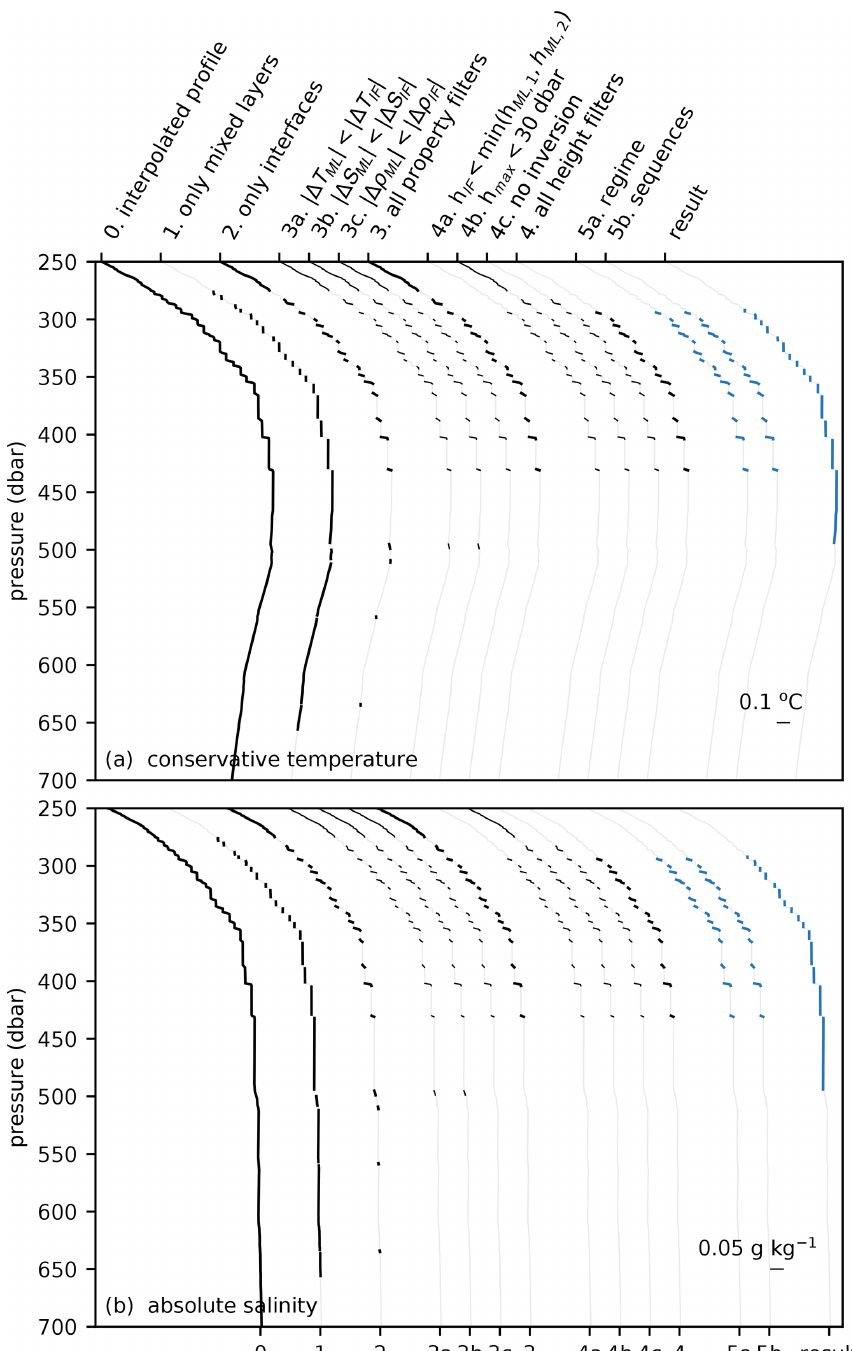
Figure A1. Steps of the detection algorithm applied to a profile in the Arctic Ocean, where steps are indicated on separate (a) conservative temperature and (b) absolute salinity profiles. Each profile is shifted for clarity. Similar to Figs. 4–6, an interface is not considered by the detection algorithm when the interface characteristics did not meet the requirements of a previous step. Original profile is taken from Ice-Tethered Profiler ITP64 at 137.8 ◦ W and 75.2 ◦ N on 29 January 2013. The details of the data preparation and the algorithm steps are discussed in Sects. 2 and 3,